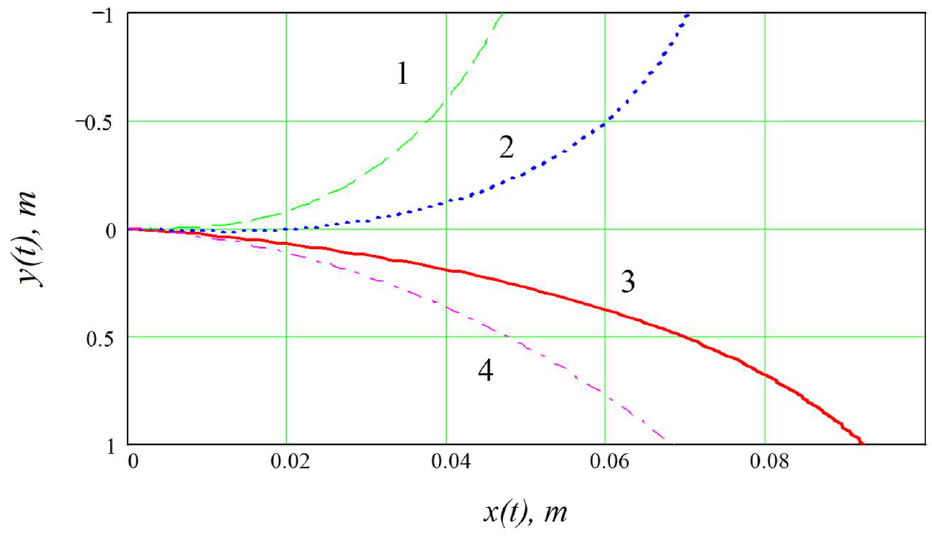
Figure 7. Trajectories of grains with different terminal velocity at V P = 7 m/s; V 0 = 0.4 m/s; α 0 = 80 ◦ ; 1—v t = 4.95 m/s; 2—v t = 6.0 m/s; 3—v t = 7.85 m/s; 4—v t = 11.0 m/s .